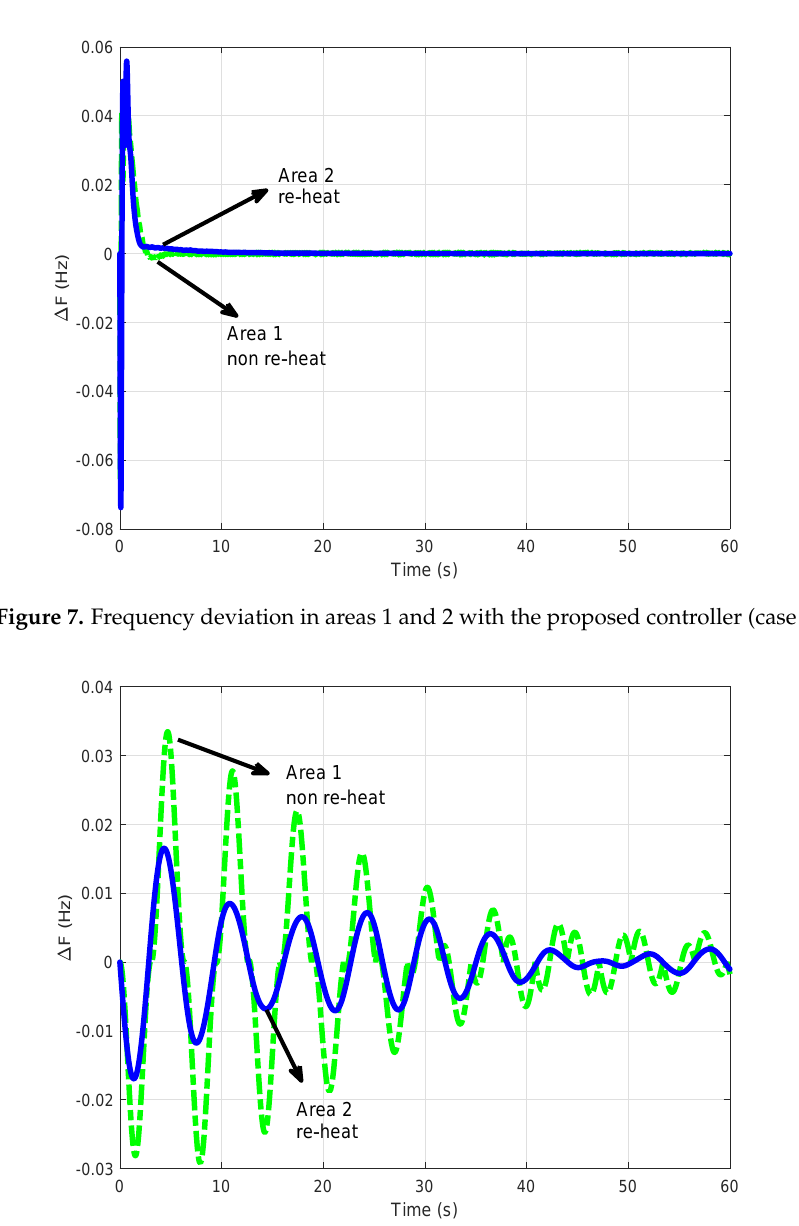
Figure 8. Frequency deviation in areas 1 and 2 with PI controller (case